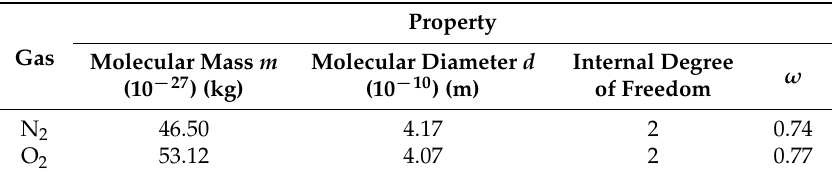
Table 2. Physical properties of N 2 and O 2 for T 0 = 273